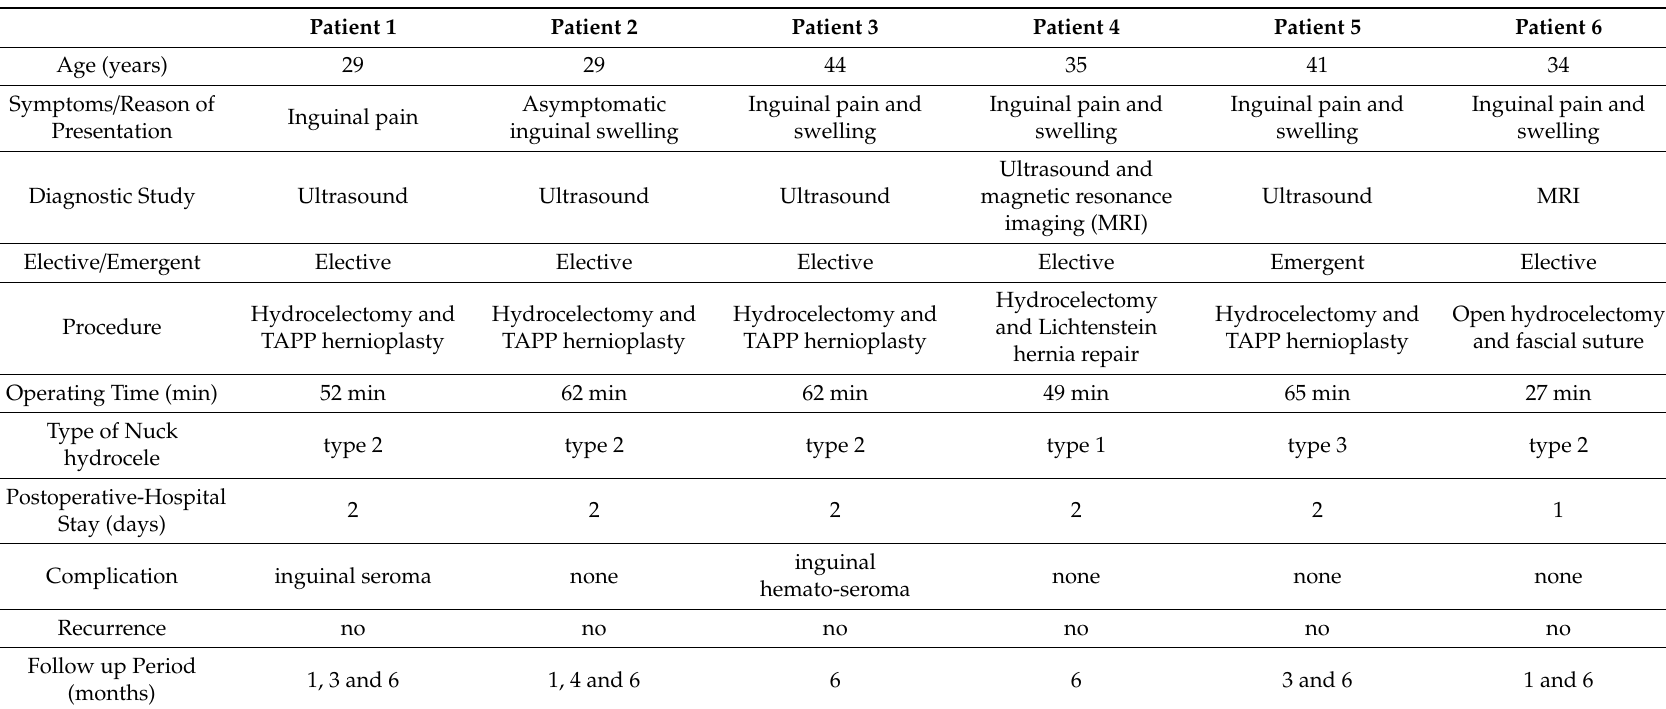
Table 1. Chart with patients treated in our institution due to a cyst of the canal of